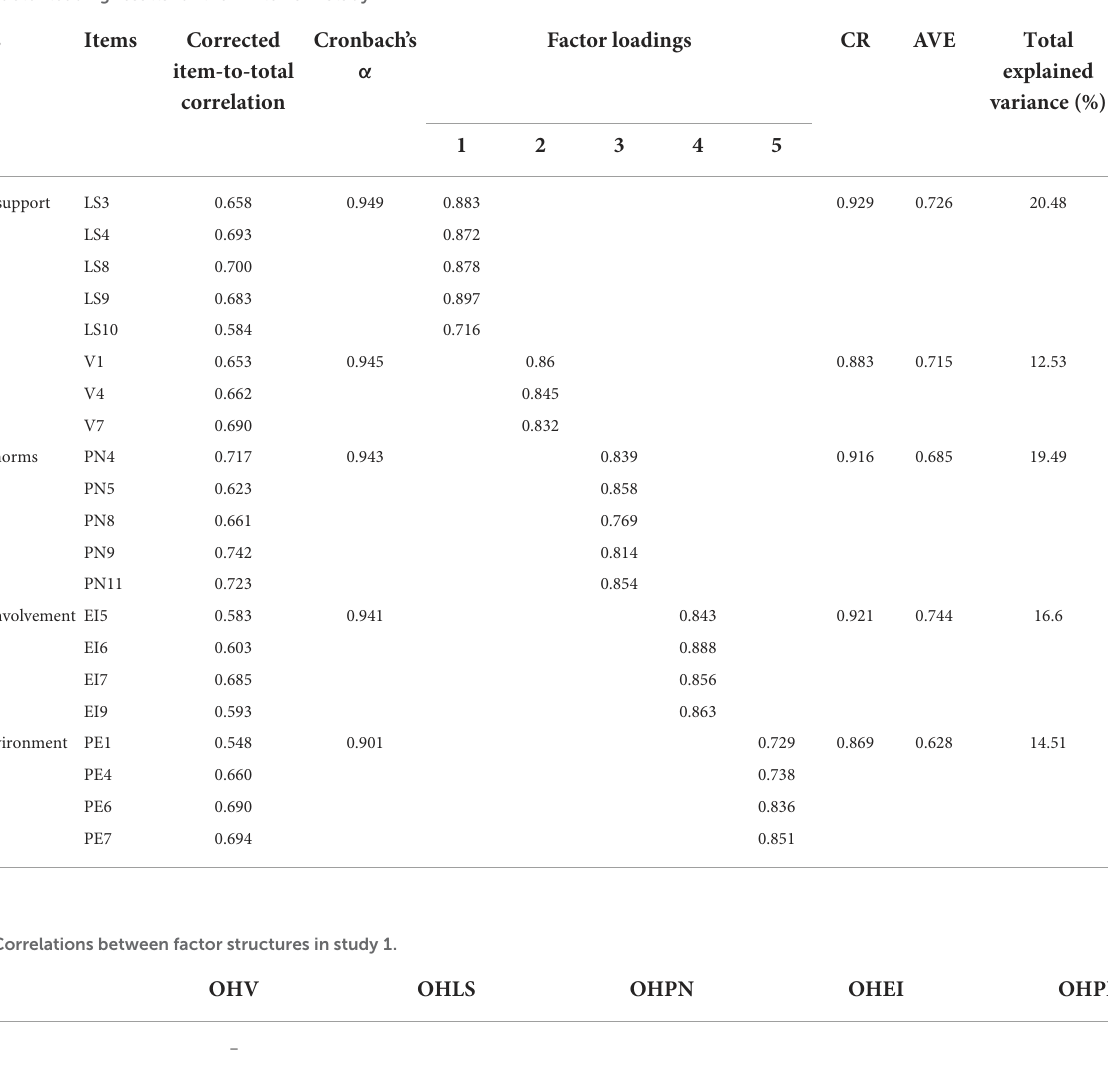
TABLE 3 Factor loading results for the 21 items in study 1.